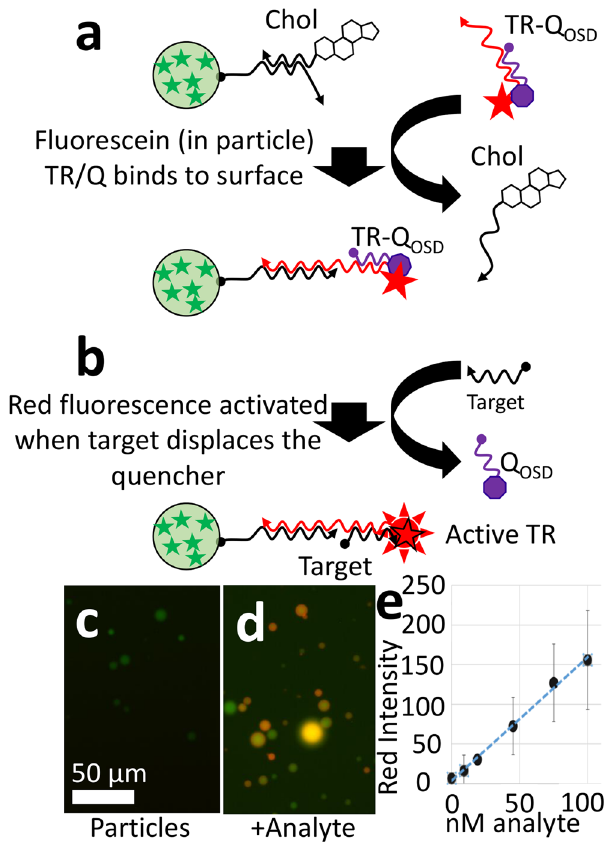
Figure 3. Demonstration of OSD reaction on particle surface. ( a ) Schematic shows how sensor particles are prepared. Cholesterol DNA is displaced by the quenched detector complex (TR-Q OSD ). ( b ) A schematic shows how the presence of TR-Q OSD was verified. A specific ssDNA displaces the quencher molecule (Q OSD ). This results in increased Texas Red fluorescence on the microparticle surface. ( c ) Fluorescence micrograph shows initial green fluorescence of the sensor microparticles. ( d ) Fluorescence micrograph shows the increased red fluorescence after addition of ssDNA. ( e ) Calibration curve shows the mean fluorescence and standard deviation among several images at various concentrations of